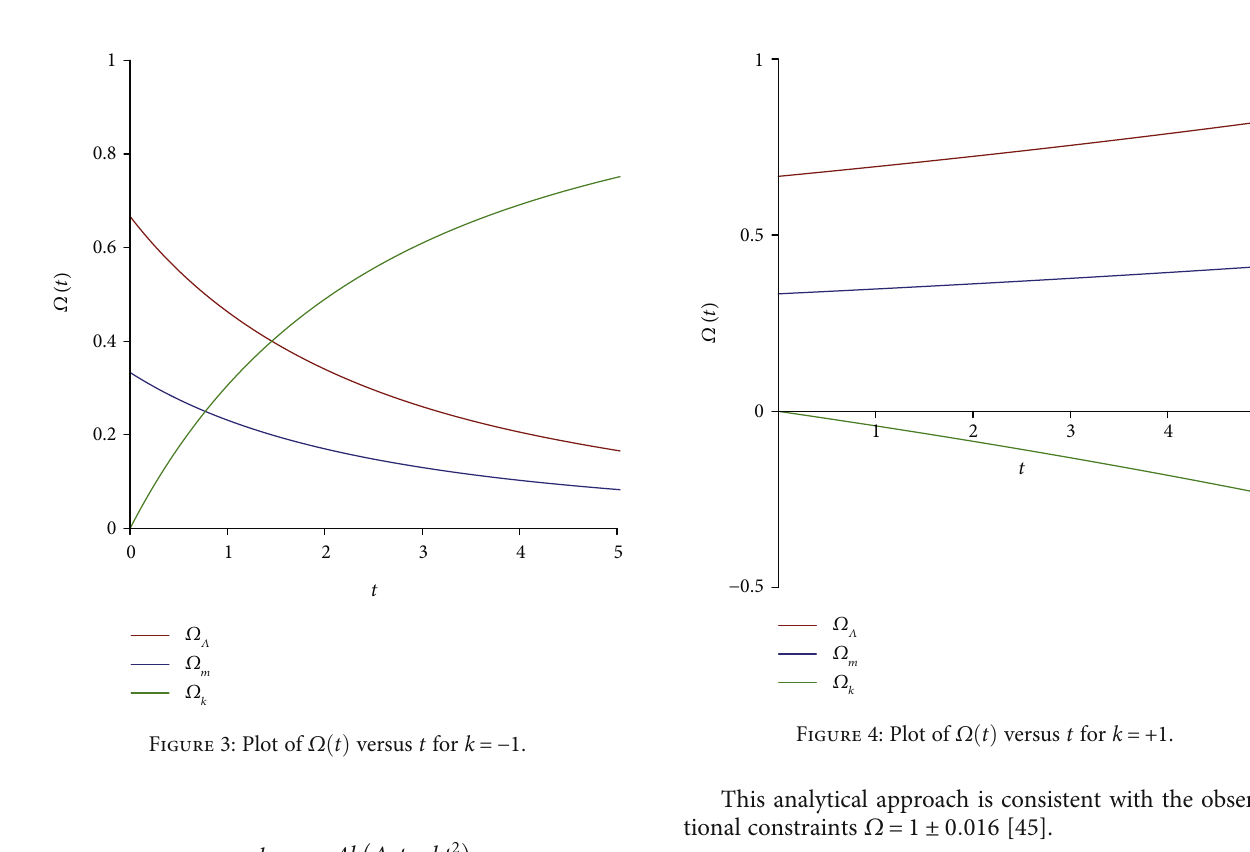
Figure 3: Plot of Ω ð t Þ versus t for k = − 1 .